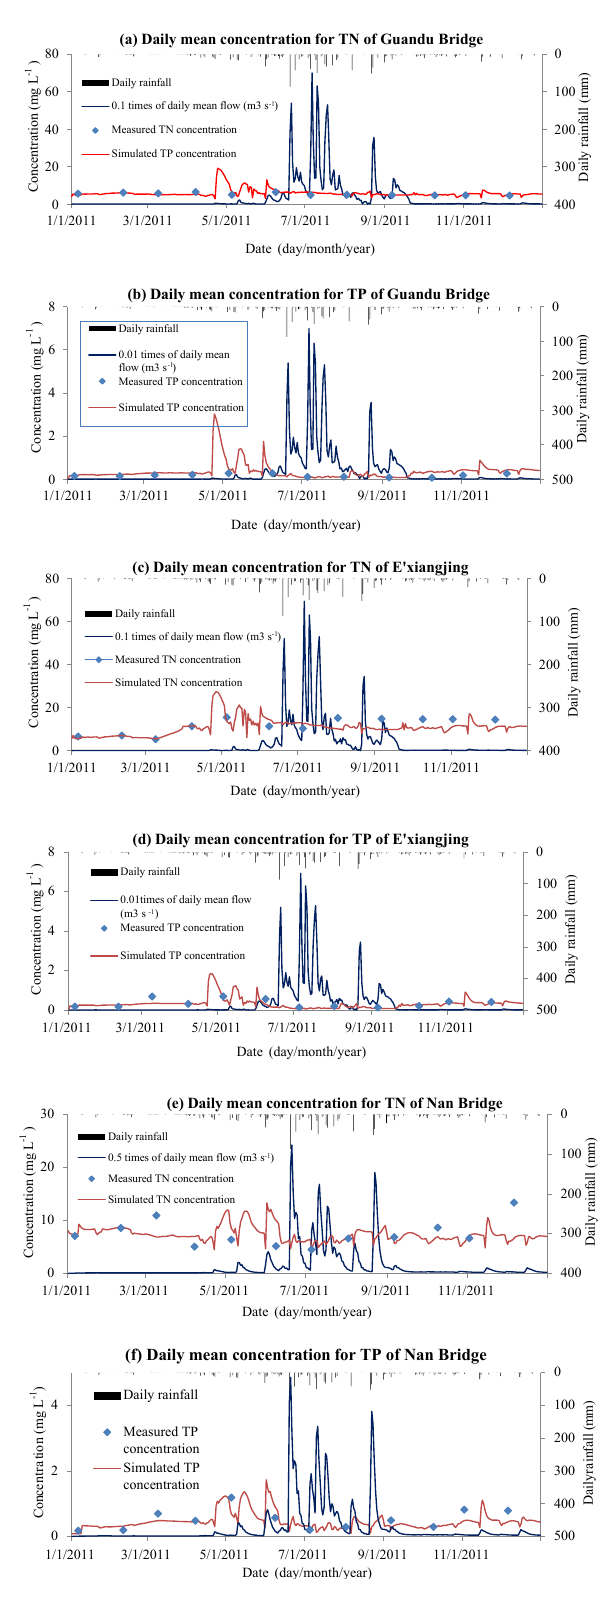
Figure 4. (a) – (f) Daily mean concentration for TN and TP of Guandu Bridge, TN and TP of E’xiangjing and TN and TP of Nan